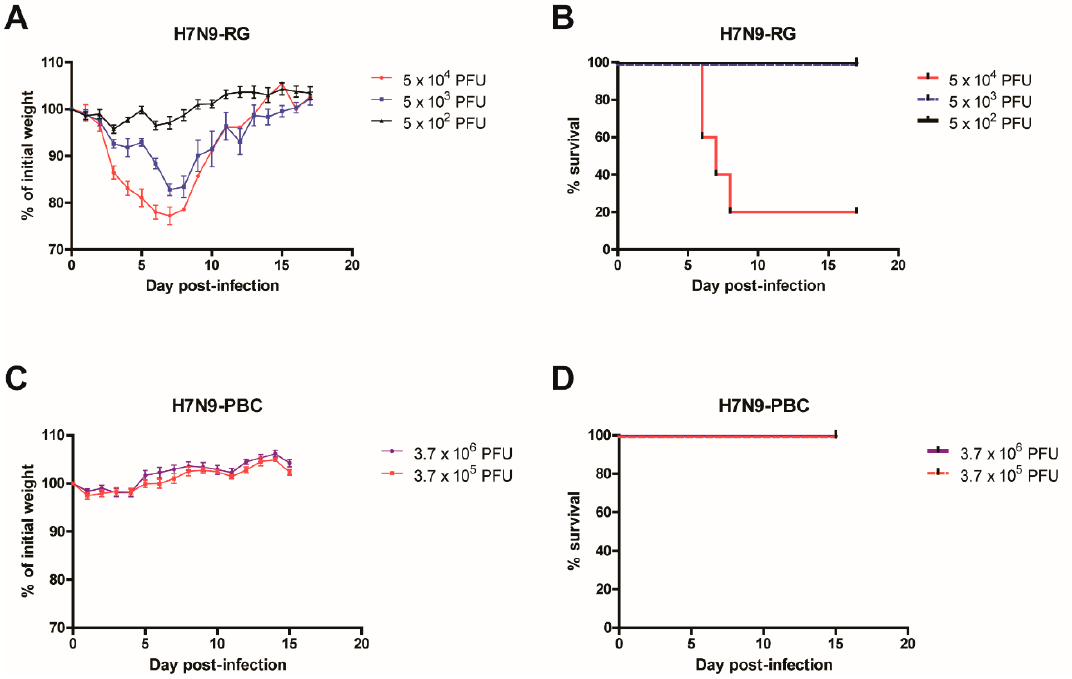
Figure 1. Virulence comparison in mice infected with reverse genetics generated influenza A/Anhui/1/2013 (H7N9-RG) virus or a version containing a polybasic cleavage site in HA (H7N9-PBC). Groups of mice ( n = 5) were infected intranasally with 10-fold serial dilutions of H7N9-RG virus, starting at a dose of 5 × 10 4 PFU. Weight loss ( A ) and survival ( B ) of H7N9-RG infected mice were measured for 17 days post-infection. For H7N9-PBC virus, groups of mice ( n = 6) were infected intranasally with either 3.7 × 10 6 or 3.7 × 10 5 PFU of virus, and weight loss ( C ) and survival ( D ) of the mice are shown.